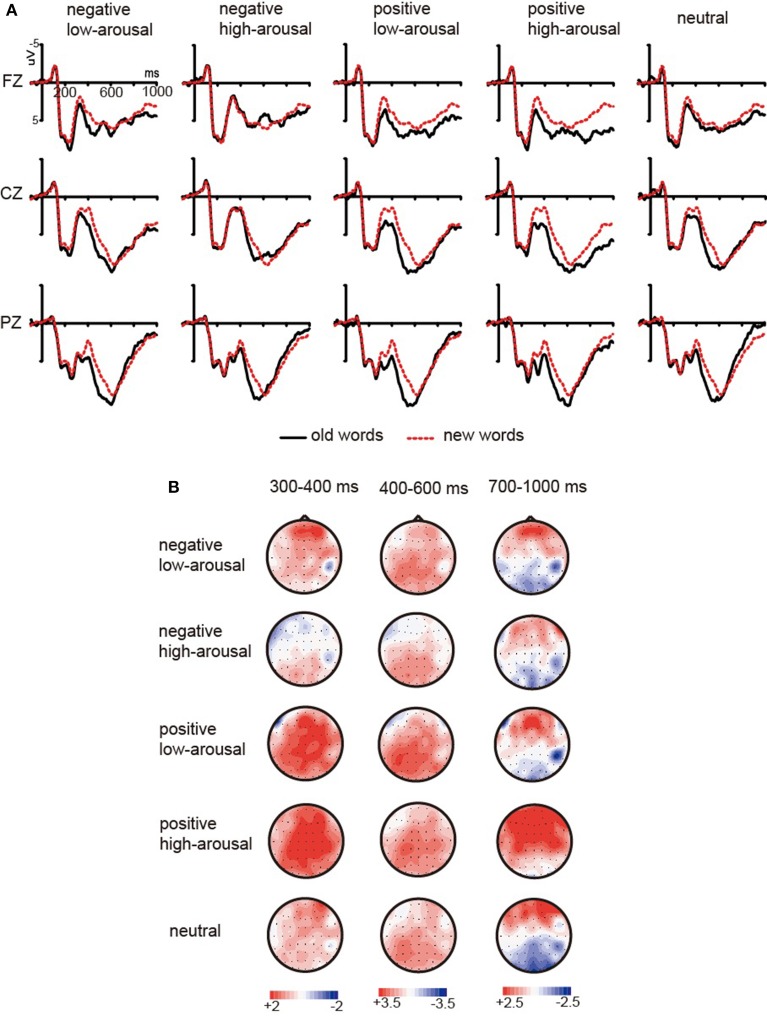
(A) ERP comparisons between new words and old words separately encoded in five types of background pictures across three scalp locations (Fz, Cz, Pz). Topographic maps (B) illustrate ERP difference waves computed by subtracting ERPs to new words from ERPs to old words across three intervals (300–400 ms, 400–600 ms, and 700–1000 ms).